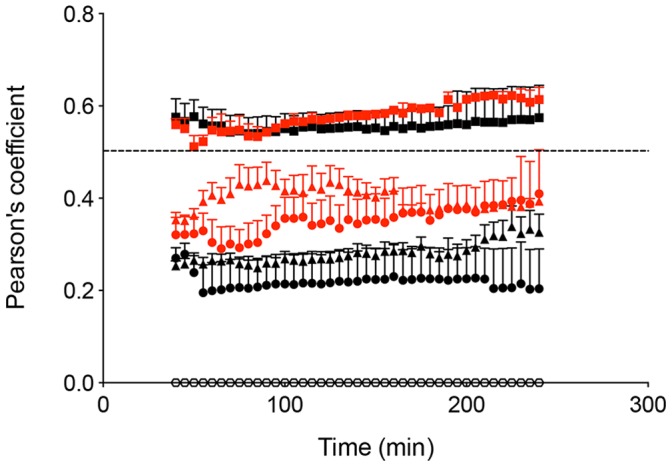
DDC-formulation colocalization.Pearson’s correlation coefficient calculated from skin treated with: an aqueous peptide mixture (•), rhodamine-labeled cubosomes (▴) and TMR peptide-loaded cubosomes (▪). The black and red colour represent intact and MN pretreated skin respectively. Unimmunized intact skin served as control (○). Cells were quantified from three randomised images from one mouse in three independent experiments. Data presented are the mean+SEM (n = 9).